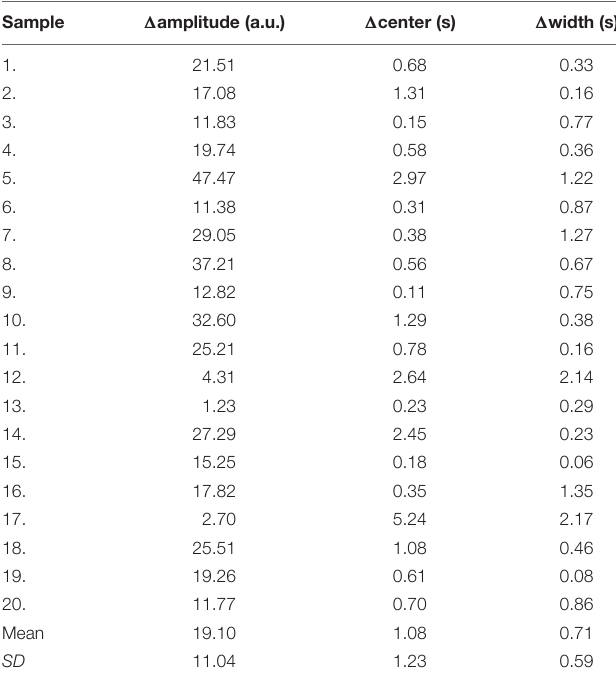
TABLE 2 | The difference of curve characteristics between the MS3DCNN and the manual method. Sample